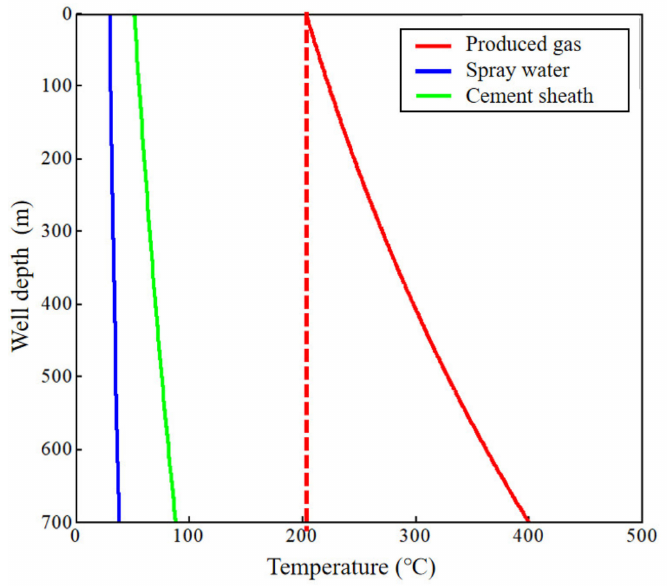
Figure 8. Temperature distribution of spray tubing injection